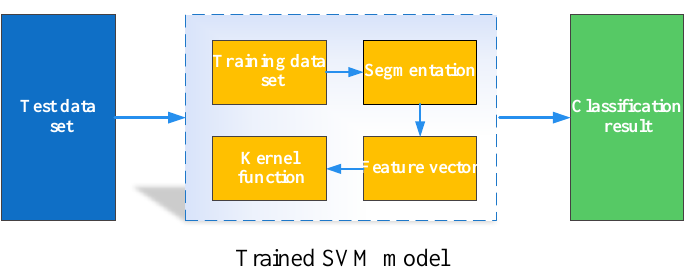
Figure 12. The entire model training process.